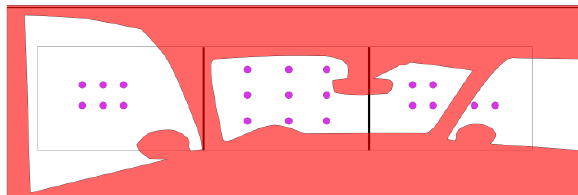
Figure 13: Calibration points